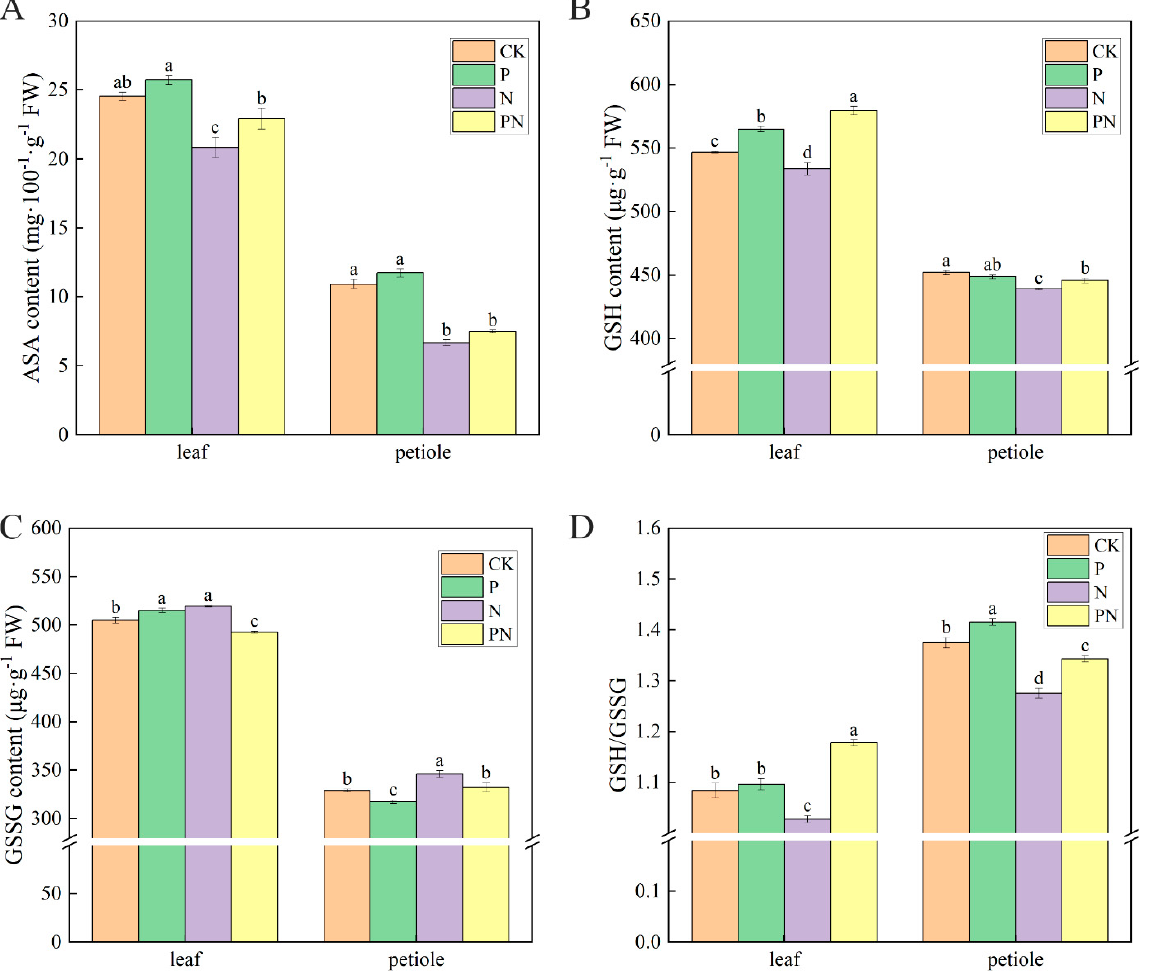
Figure 9. Effect of exogenous proline on the content of non-enzymatic antioxidant substances in celery under salt stress. After planting the 35-day-old seedlings for 7 days, they were treated with 0.3 mM proline solution for 7 days, after which they were watered with 100 mM NaCl solution thrice every 3 days. ( A ) Reduced ascorbic acid (ASA) content. ( B ) Glutathione (GSH) content. ( C ) Oxidized glutathione (GSSG) content. ( D ) GSH/GSSG. The results are expressed as the mean ± SE of three replicates, and the different letters denote the significant difference among treatments ( p < 0.05), according to Duncan’s multiple tests. CK, control. P, 0.3 mM proline. N, 100 mM NaCl. PN, 100 mM NaCl+ 0.3 mM proline.